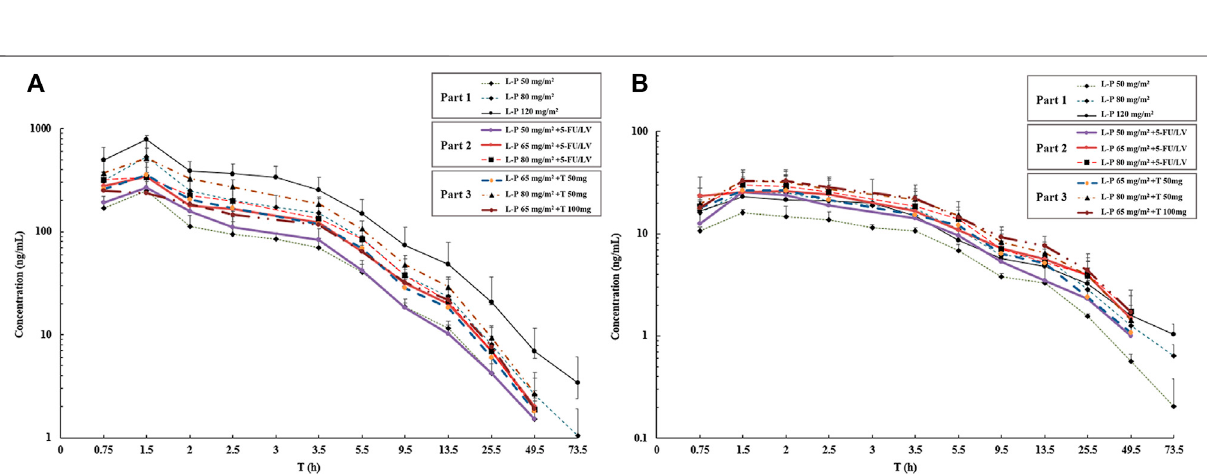
Frontiers in Pharmacology |